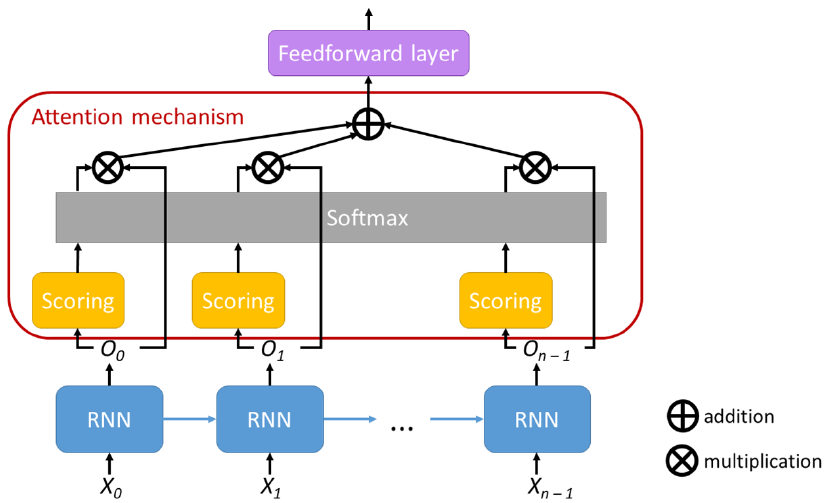
Figure 6. Attention mechanism designed at network